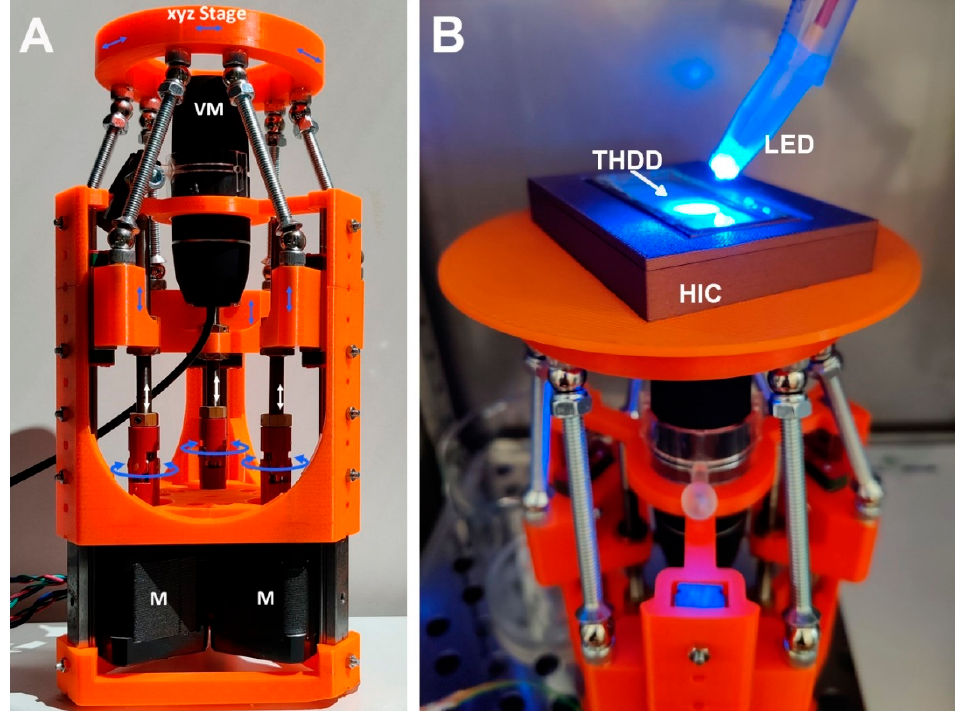
Figure 2. The delta kinematic microscopic stage/chip monitoring microscope, δ -M, with an incubation chamber. ( A ): For the on-chip observation of hanging drops, a microscope stage was 3D-printed and assembled, enabling controlled movements in a 3D fashion (XYZ stage), driven by accurate stepper motors (M); In the central position, a USB camera (VM) was mounted for acquiring photomicrographs from underneath (for a detailed description, see Supplementary Materials); ( B ): a delta kinematic microscope stage holding a humidifying incubation chamber (HIC) containing a Teflon hanging drop device (THDD), completely illuminated by a blue-light emitting diode (LED).